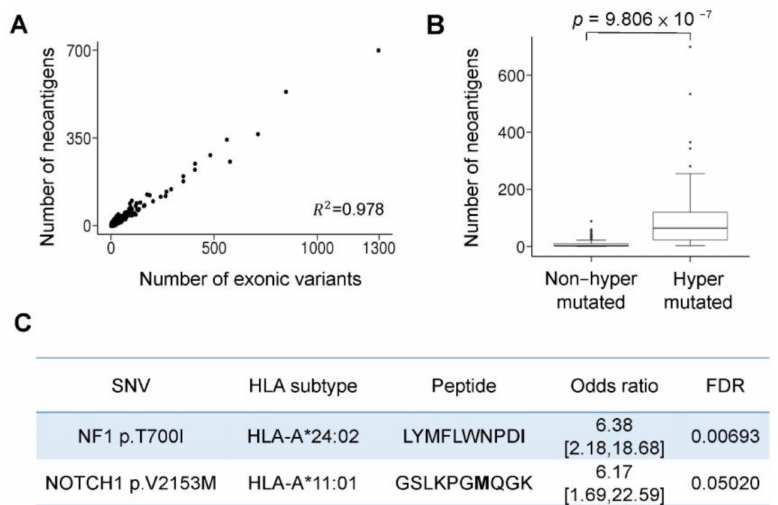
Figure 3. Hypermutation-derived neoantigens. ( A ) The correlation between exonic variants and the number of strongly binding neoantigens in the 533 patients. There is a strong relationship ( p- value = 0.978 by Pearson’s correlation) between tumor mutational burden and neoantigens. ( B ) Neoantigen numbers by subgroups. The hypermutated group possesses more neoantigens than the nonhypermutated group, with median values of 64 and 3 neoantigens, respectively; p -value = 9.806 × 10 − 7 by t -test. ( C ) Neoantigens in the hypermutated group. Two novel neoanti- gens were identified, NF1 p.T700I and NOTCH1 p.V2153M. An odds ratio was used to determine the correlation between hypermutation and neoantigens. The p -value was adjusted for FDR (false discovery rate). *